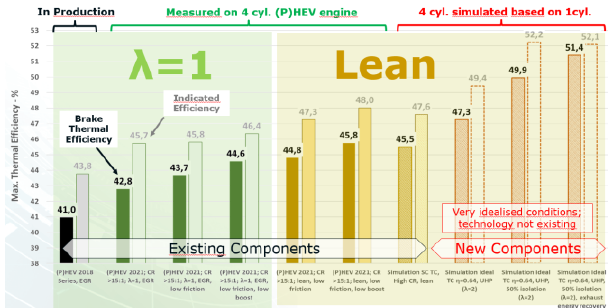
Fig. 5. Efficiency projections of a hybrid 4-cyliner engine using existing and future technologies [29] Emissions legislation in Europe have undergone a